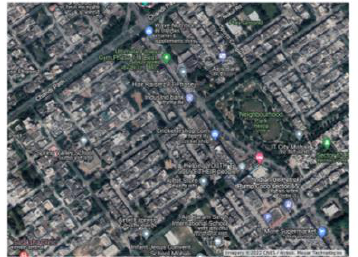
Figure 2. Google satellite Basemap layer